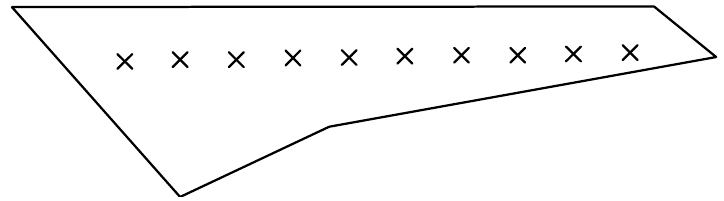
Figure 12. Locations of accelerometers and strain gauges on the surface of the